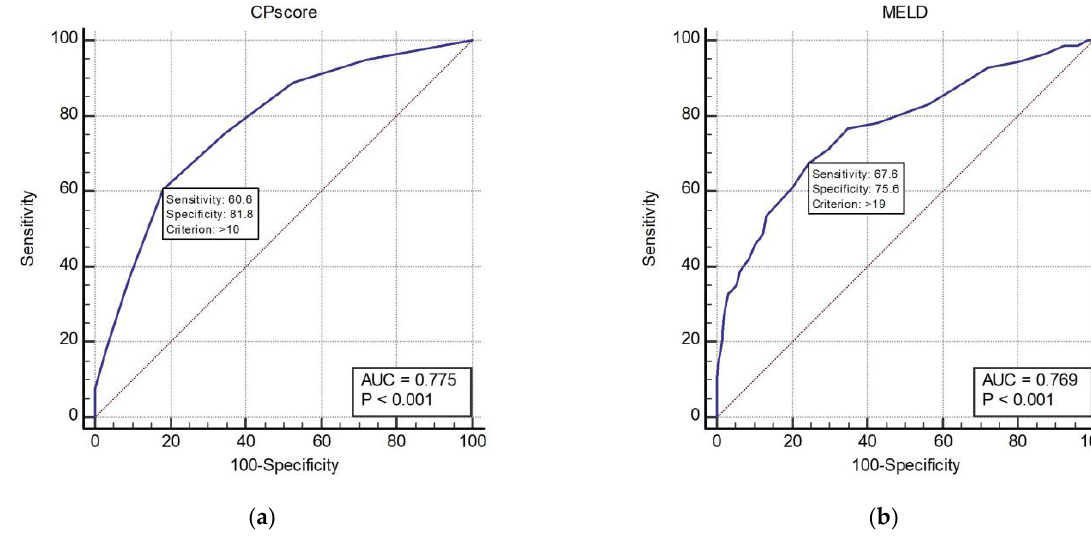
( d ) Figure 4. Receiver operating characteristic curves (ROC) and area under the ROC (AUROC) of pa- tients with CP classes B and C for 3 - month mortality. ( a ) CP score for 3 - month mortality, 0.775 (95% CI, 0.746–0.803); ( b ) MELD for 3 - month mortality, 0.769 (95% CI, 0.739–0.797); ( c ) MELD - GRAIL - Na for 3 - month mortality, 0.786 (95% CI, 0.757–0.813); ( d ) comparison of AUROC for 3 - month mortality between the CP, MELD, and MELD - GRAIL - Na scores. 4. Discussion Over the years, ongoing efforts have been made to estimate and predict mortality in patients with cirrhosis. The CP scoring system could be easily used as it comprised five variables (i.e., serum bilirubin, albumin, prothrombin time, ascites, and encephalopathy). Since the presence and amount of ascites and grade of encephalopathy are a subjective variable, efforts to overcome subjectivity may have led to the development of MELD. MELD has been the optimal scoring system for mortality prediction and transplant allo- cation prioritization, but as new studies and research have been introduced, MELD has demonstrated some shortcomings. Studies have shown that hyponatremia and renal function are crucial factors for morbidity and mortality among patients with cirrhosis [4,5,10,11]. MELD - Na, Refit - MELD, and Refit - MELD - Na are a result of the integration of sodium and renal function into the MELD [2–4]. Recently, the newly designed ‘GRAIL’